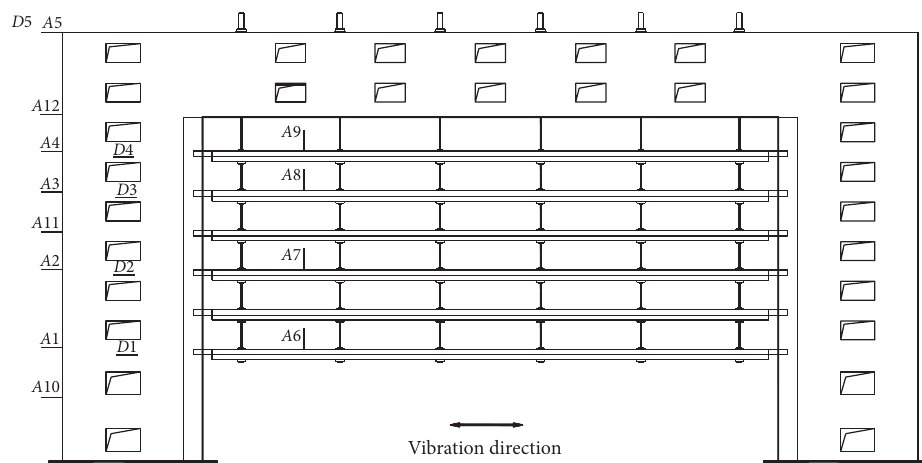
Figure 6: Layout of the displacement and acceleration sensors. Table 4: Frequency and damping ratio of the